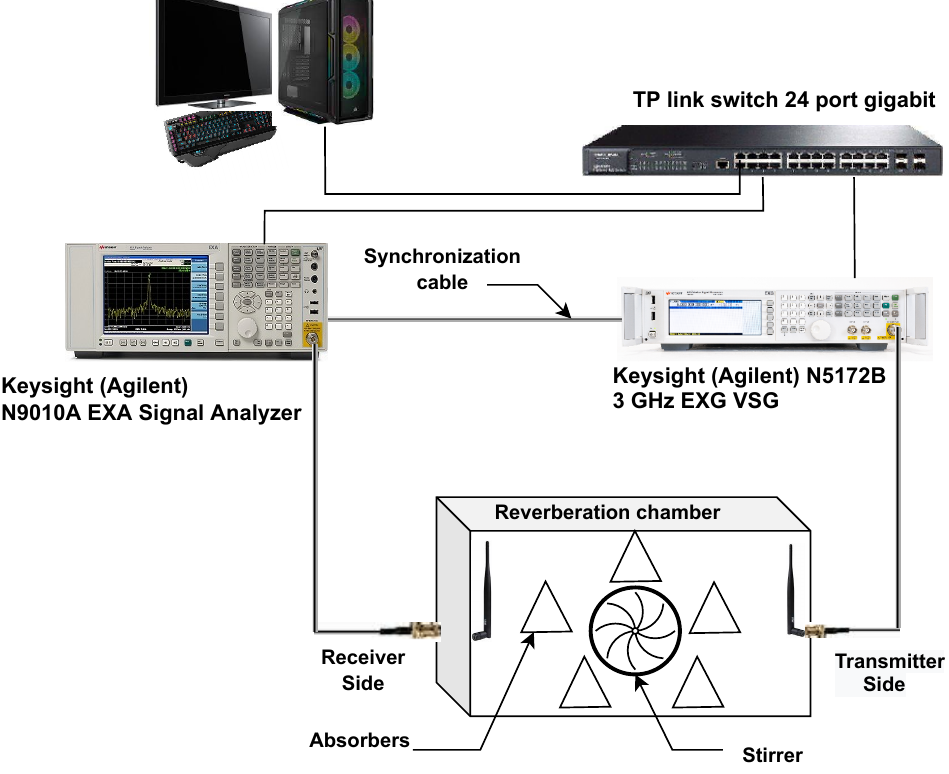
Figure 3. Laboratory equipment setup connection for multi-path emulation using reverberation